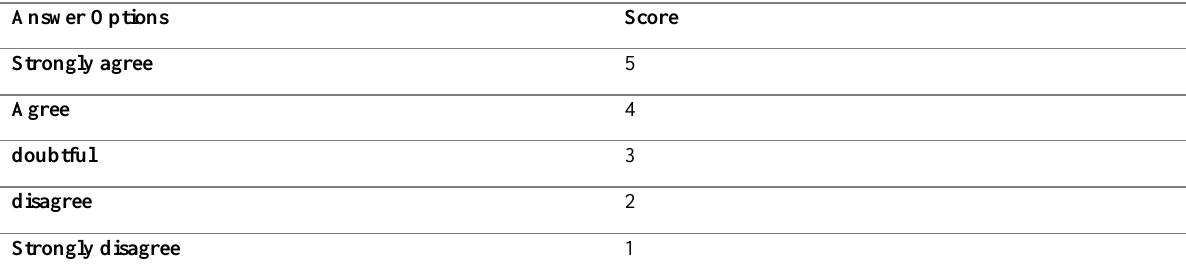
Table 1: Question Items and Scores